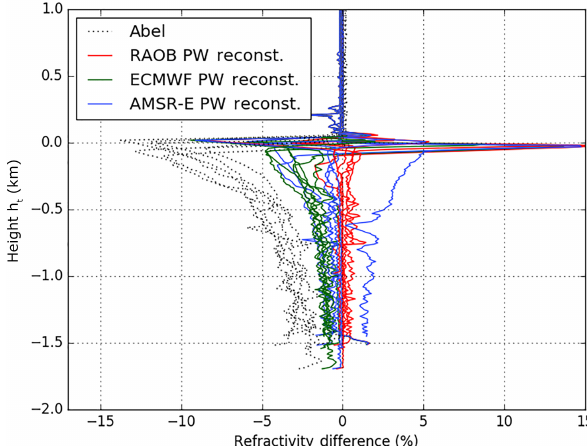
Figure 7. Refractivity differences of the Abel-retrieved and the re- constructed profiles from different PW sources compared to the original RAOB profiles in the six simulated cases. It can be seen that the results using ECMWF PW are negatively biased ( − 1 to − 5%) while the collocated AMSR-E reconstructed results more closely aligned with the RAOB profiles. An outlier of the AMSR-E recon- struction shown in the figure is case 5, which was measured 431km away from the corresponding RAOB